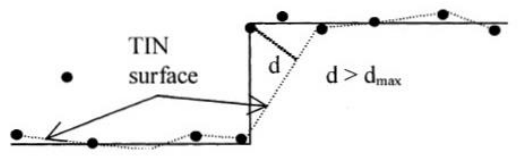
Figure 3. Facet planes and angles to the nodes (Axelsson, 2000).